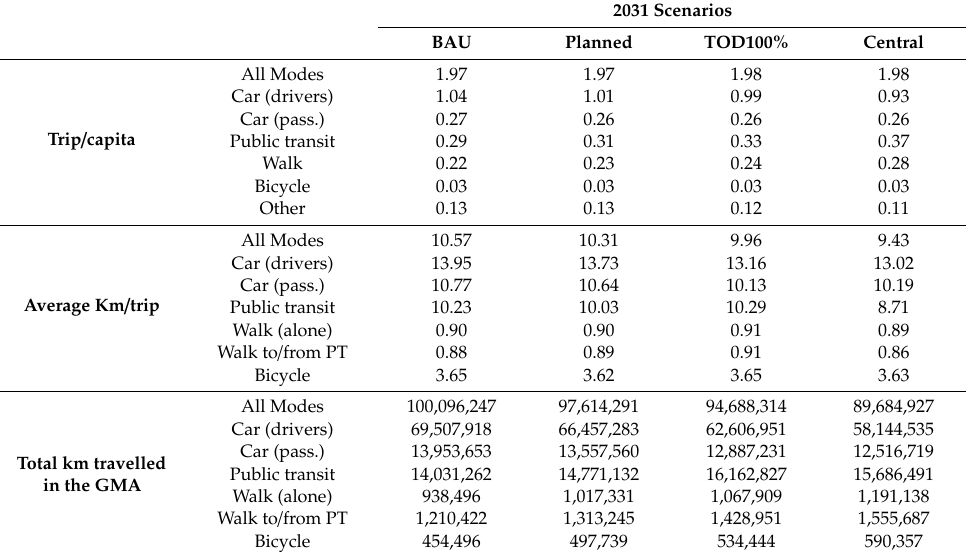
Table 3. Daily number of trips and distances travelled by mode (according to the method based on 2008 mode shares), for the 2031 scenarios for the Greater Montreal